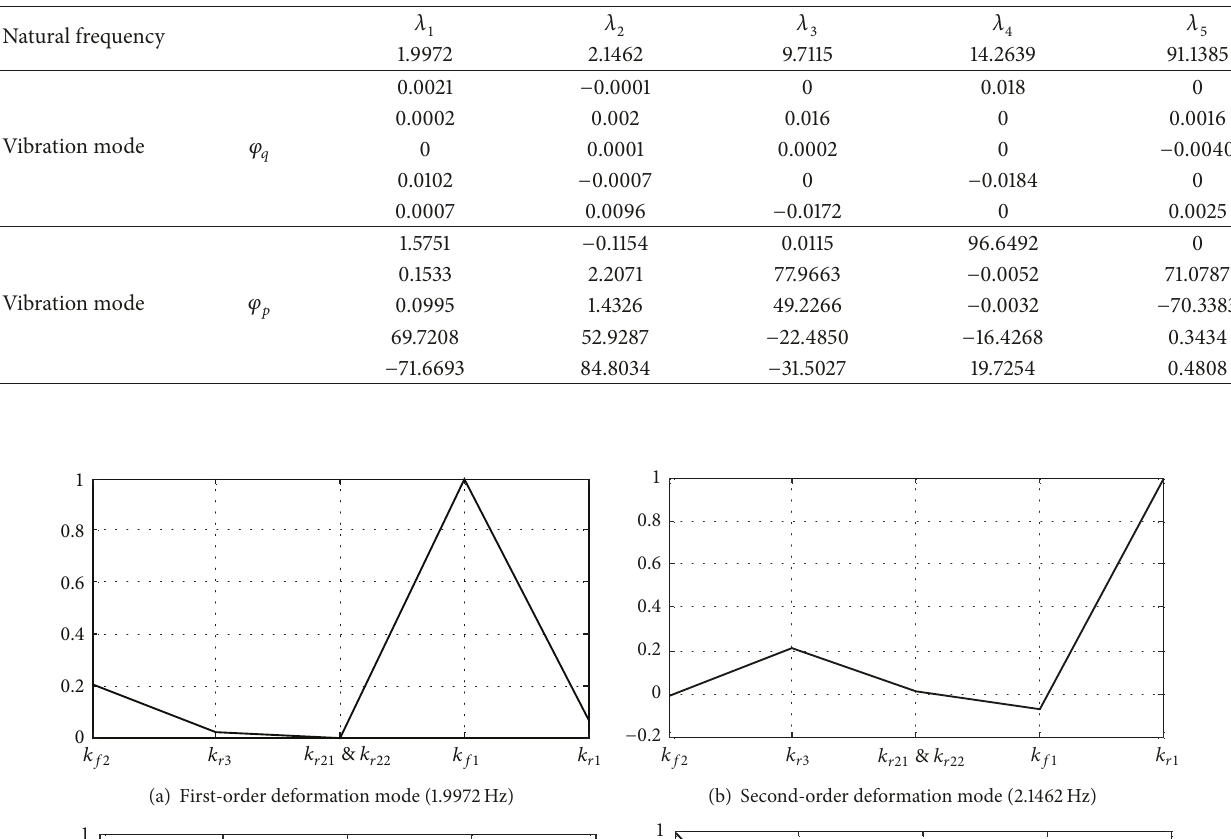
Table 2: Natural frequencies and vibration modes.